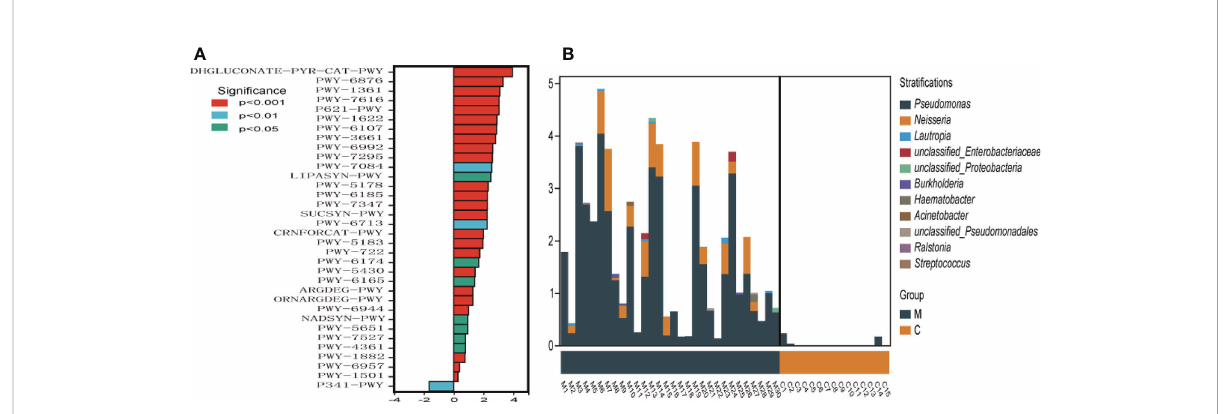
FIGURE 5 Metabolic pathway difference analysis (A) , positive value of logFC (log2(fold change)) on the horizontal axis represents upregulation in group M (methamphetamine using) compared with that in group C (control), whereas the negative value represents downregulation. The ordinates indicate different Pathway tags. (B) Species composition diagram of the glucose degradation (oxidative) metabolic